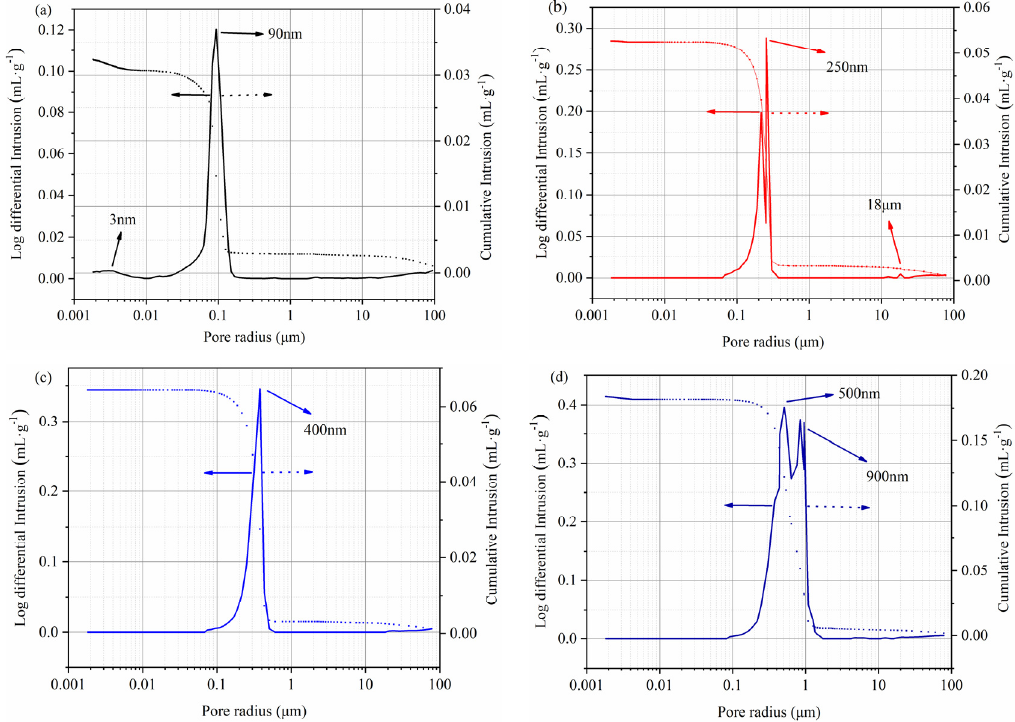
Figure 6. Pore size distribution of porous alumina with different quantities of the pore-forming agent, corresponding to ( a ) 20 vol.%, ( b ) 30 vol.%, ( c ) 40 vol.%, and ( d ) 50 vol.%.